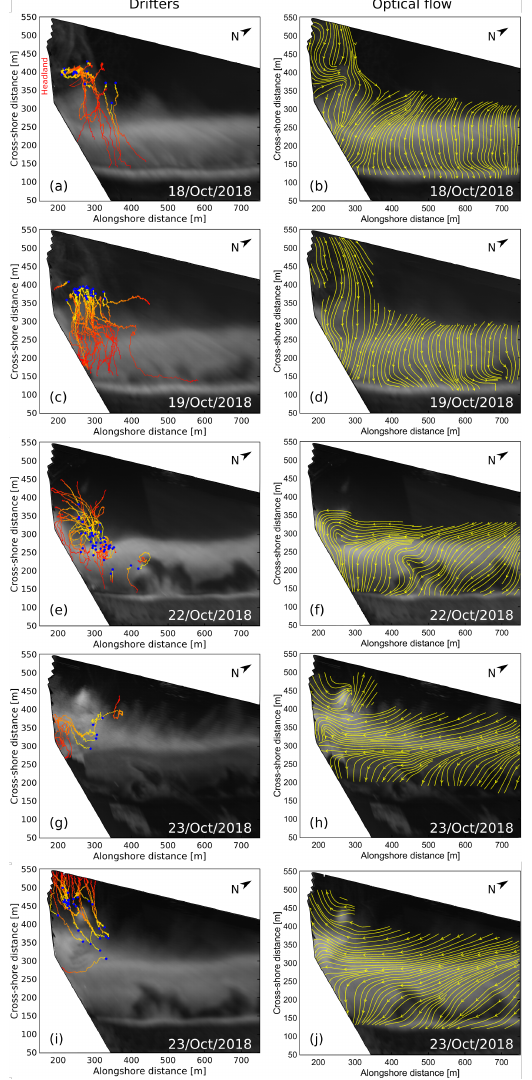
Figure 9. Drifter trajectories (left panel) and optical flow image-derived velocity stream plots (right panel) corresponding to ( a , b ) 18, ( c , d ) 19, ( e , f ) 22 and ( g – j ) 23 October 2018. ( g , h ) Neap low tide and ( i , j ) rising low tide on 23 October 2018. For each event, the pixel intensity standard deviation image is overlaid to highlight wave breaking spatial variability and foam availability. The blue points indicate the location of drifter seeding. The headland is located within the white masked image region between 0 and 150 m in the alongshore